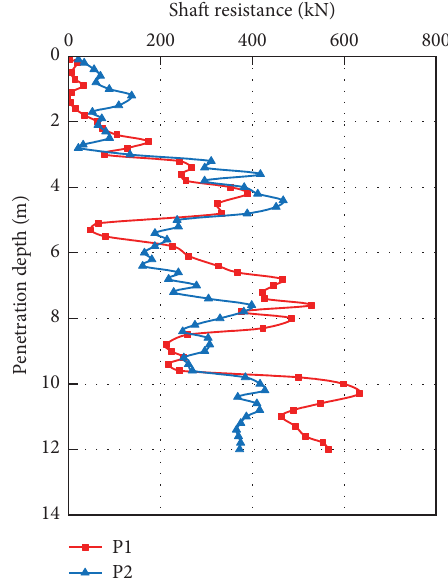
Figure 6: Shaft resistance versus penetration depth.